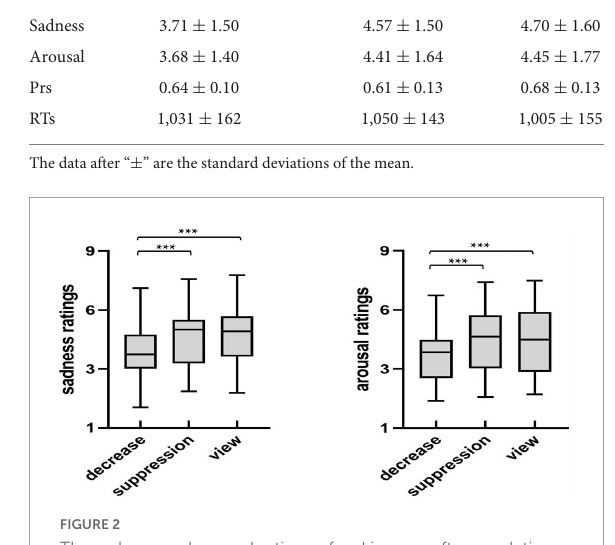
TABLE 2 The average sadness, arousal ratings, recognition accuracy Prs, and recognition RTs (ms) of the stimuli groups in this study. Down-regulation reappraisal